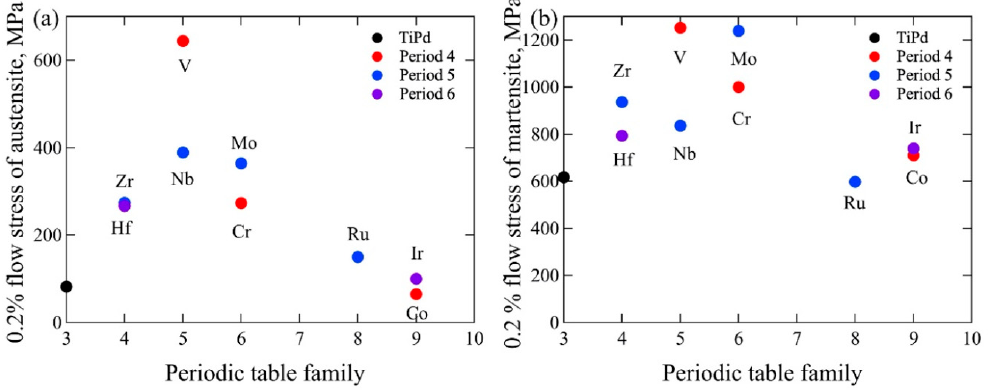
Figure 3. The 0.2% flow stress of the austenite and martensite phases of TiPd [33]: ( a ) Ti 45 Pd 50 X 5 (X = Zr [33], Hf [34], V [34], Nb [34], Cr [34], and Mo [34]) and ( b ) Ti 50 Pd 46 Y 4 (Y = Ru, Co, and Ir) [37] for the periodic table